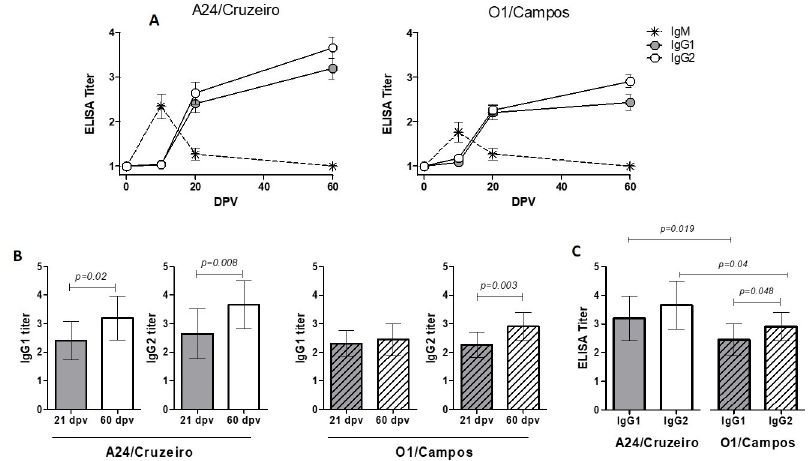
Fig 2. Isotype responses. (A) Kinetics of IgM, IgG1 and IgG2 in vaccinated pigs, mean titers ± SD are depicted. (B) Comparison of mean IgG1 and IgG2 titers at 21 and 60 dpv against both A24/Cruzeiro and O1/Campos strains. (C) Pairwise comparative analysis of IgG1 and IgG2 levels measured at 60 dpv.